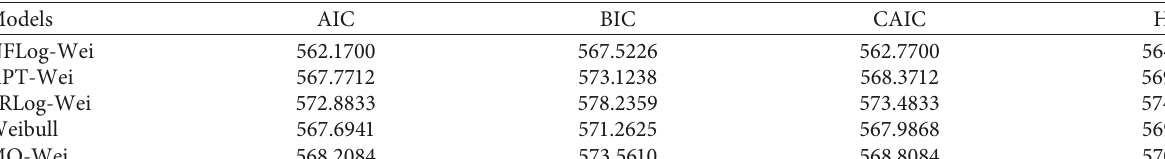
Table 6: The values of AIC, BIC, CAIC, and HQIC of the fitted models for Data 1.